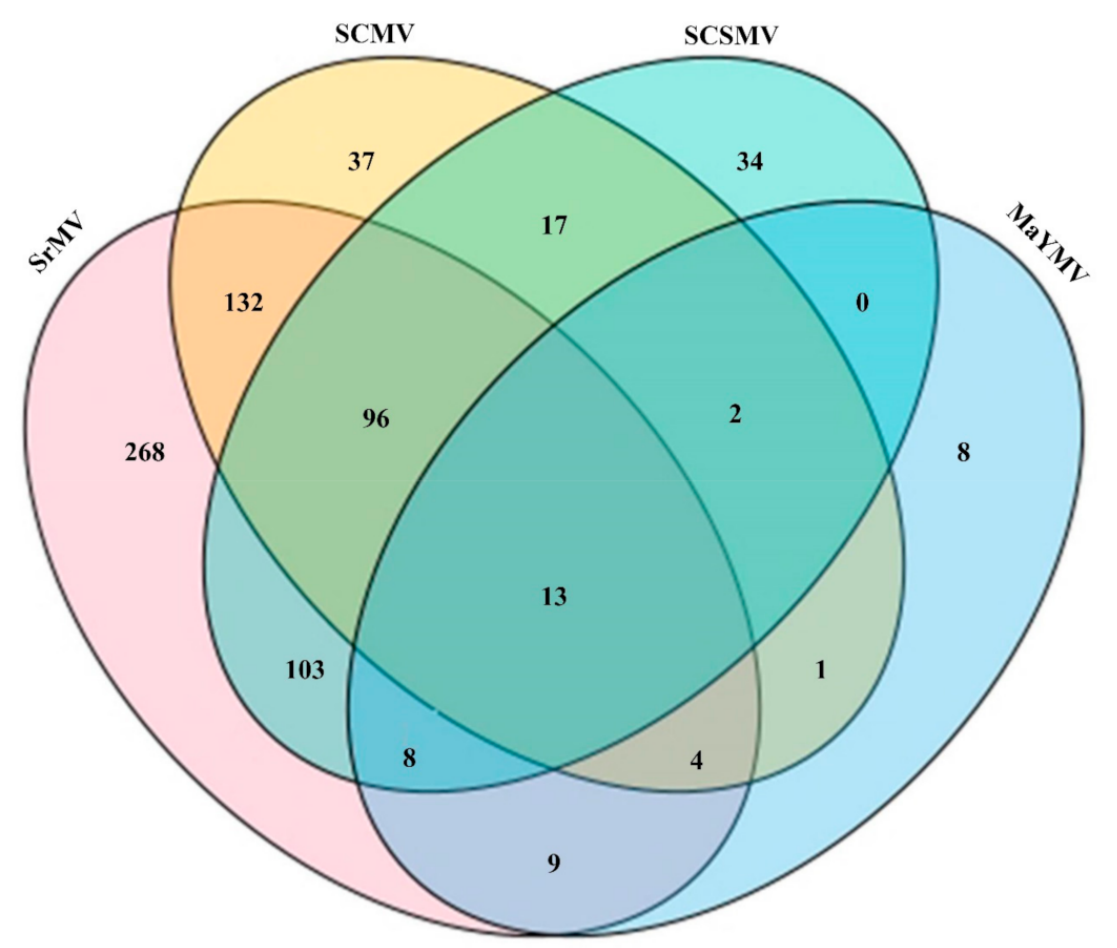
Figure 3. Venn diagram for single or mixed infection by four viruses (SrMV, SCMV, SCSMV, and MaYMV) in 731 virus-positive sugarcane leaf samples determined by